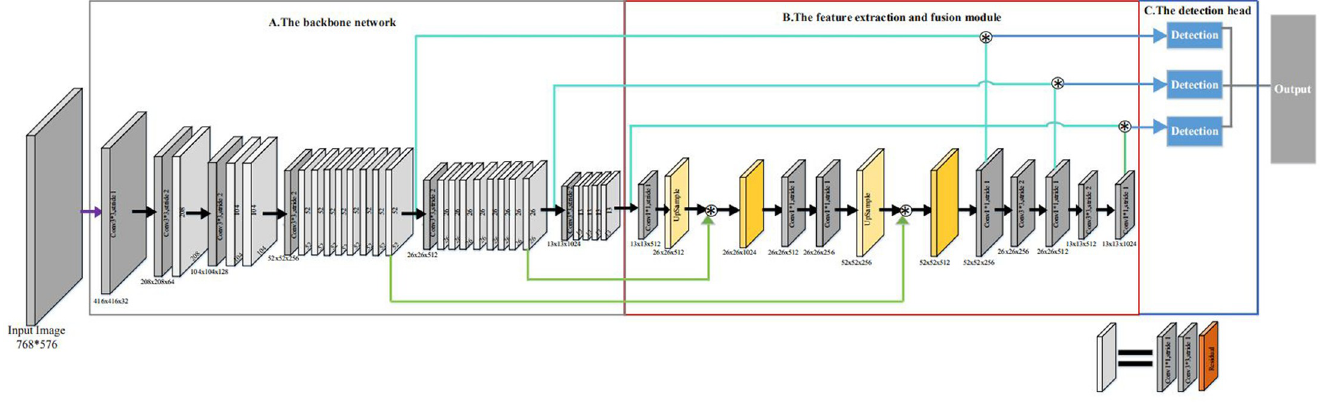
Fig 2. Architecture of our